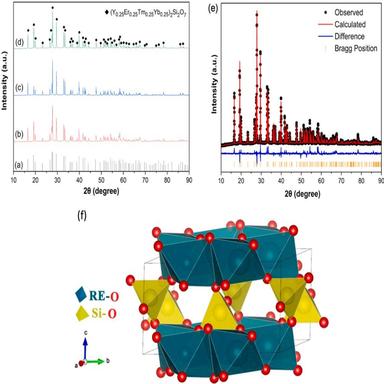
(a) Reference pattern of Yb2Si2O7 (PDF: #37–0458), the XRD patterns of (Y0,25Er0,25Tm0,25Yb0,25)2Si2O7 samples sintered at 1600 ℃ for (b) 12 h, (c) 18 h, (d) 24 h and (e). Rietveld refinement result of (Y0,25Er0,25Tm0,25Yb0,25)2Si2O7 and (f) illustrative crystal structure of the β-type high entropy disilicate.